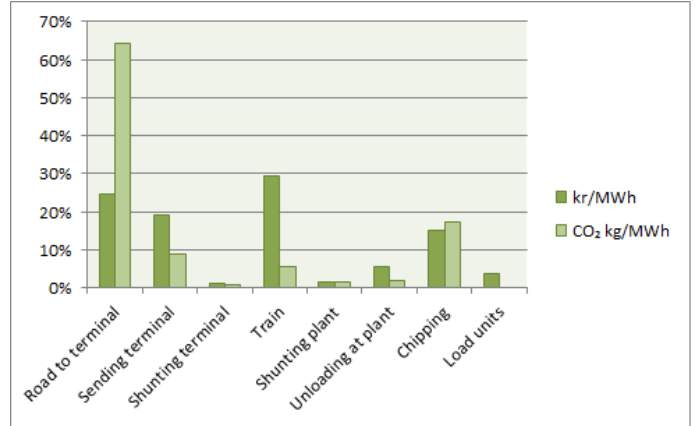
Figure 7. CO 2 emission and costs distribution when chipping at the terminal.